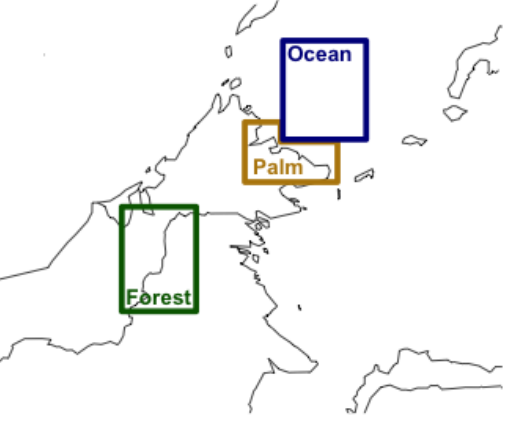
Figure 13. The three regions in northeastern Borneo used for the spatial filtering of the satellite